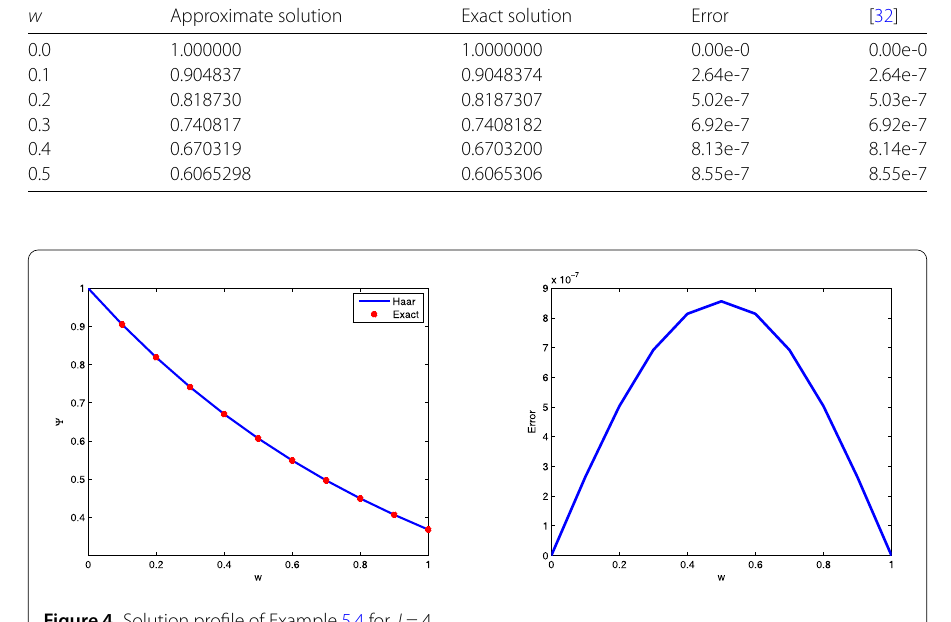
Figure 4 Solution profile of Example 5.4 for J =